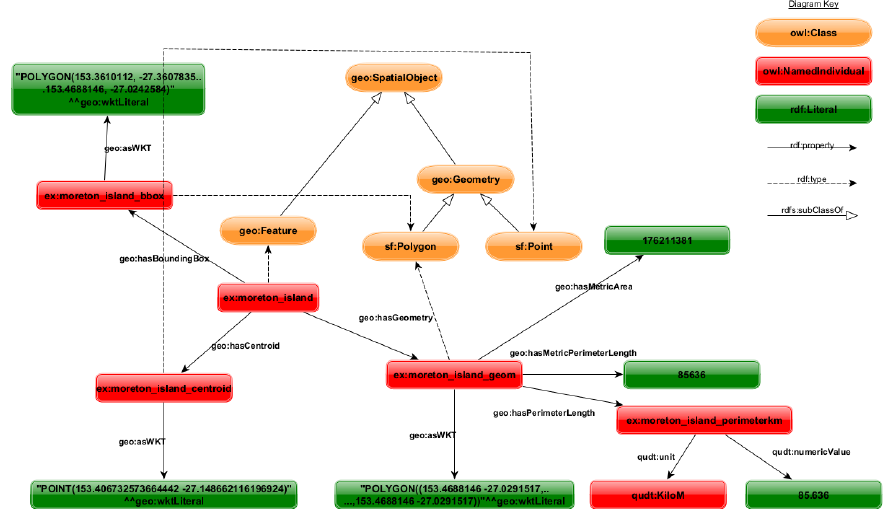
Figure 2. Excerpt of the GeoSPARQL 1.1 ontology including one example feature.